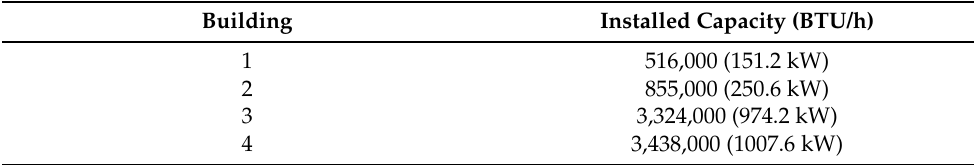
Table 5. Conditioned loads: total installed capacity by